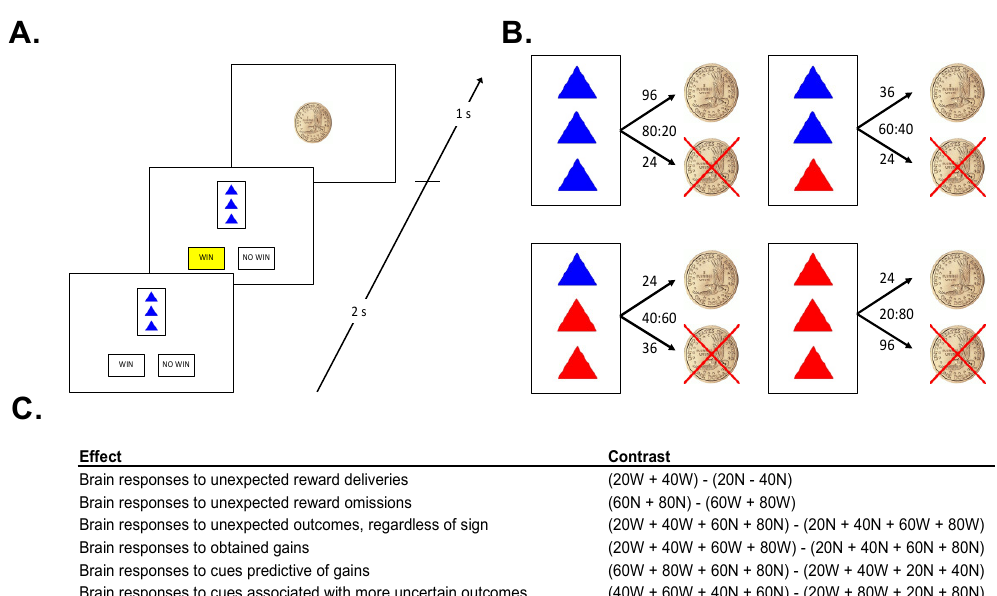
Figure 1. ( A ). Sample Trial: On each trial, participants were presented with 1 of 4 cues, then predicted the outcome of the cue (“WIN” or “NO WIN”) and were shown an outcome. ( B ). Cues : The task consisted of 4 different cues. Numbers above arrows indicate the number of trials that the cue resulted in each outcome, ratios denote win probabilities (WIN:NO WIN). ( C ). Neuroimaging Contrasts : five contrasts were analyzed to examine different types of salience.